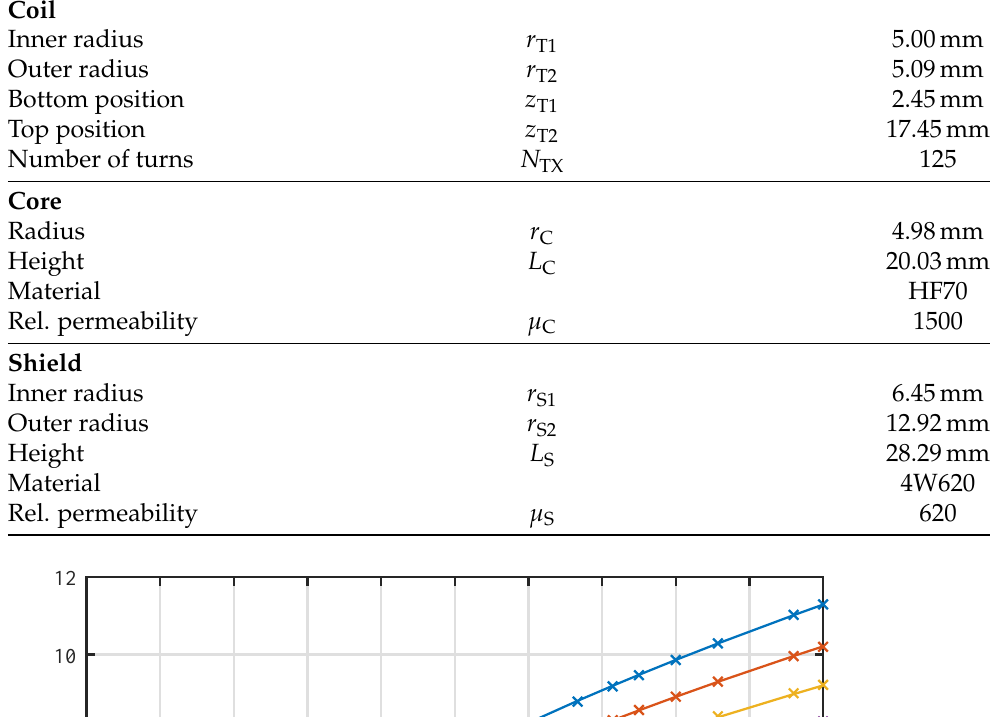
Table 2. Properties of the sensor prototype.